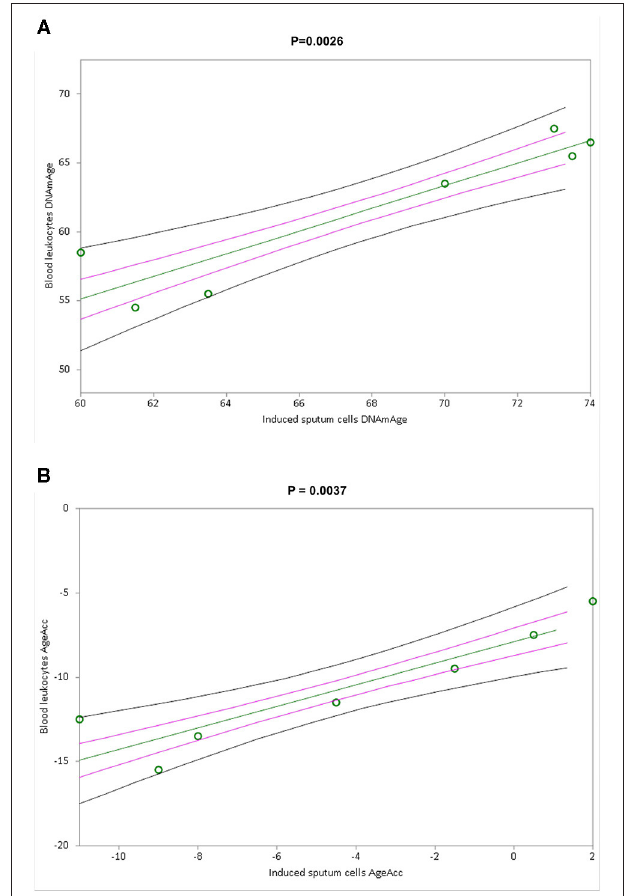
FIGURE 3 | Correlation curves between blood leukocytes DNAmAge (A) or AgeAcc (B) and chronological age of n = 16 COPD patients. In (A) , a simple linear regression plot shows the correlation between blood leukocyte DNAmAge and chronological age [correlation coefficient (r) = 0.836142; two-sided p < 0.0001], while in (B) , simple linear regression linear regression plot showing the correlation between blood leukocyte AgeAcc and chronological age [correlation coefficient (r) = − 0.53542; two-sided p = 0.0326]. Mean, standard error (SE), and 95% coefficient intervals (CI) are represented as green, pink, and black lines, respectively.